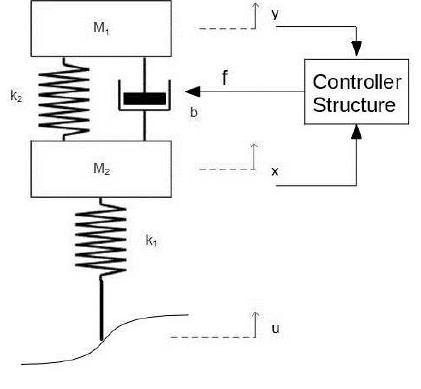
Figure 1. Quarter car suspension